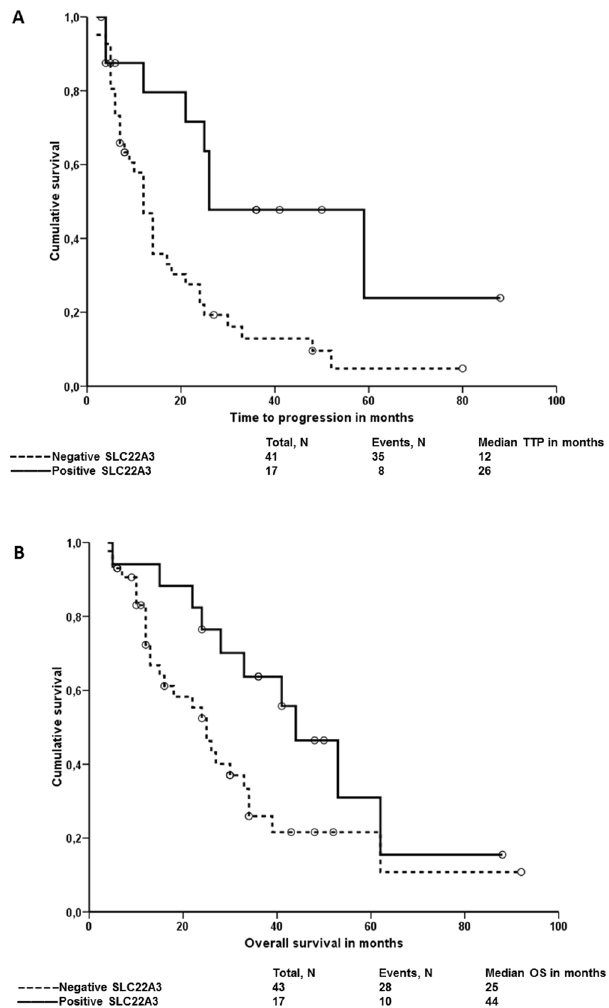
Figure 2. Associations between SLC22A3 brush border staining and the survival of all patients. Kaplan-Meier survival curves were plotted for the PFS or the OS of patients divided into negative and positive staining groups. Dashed line represents the group with negative staining and solid line the group with positive staining. Plot ( A ) shows results of PFS analysis and plot ( B ) of OS